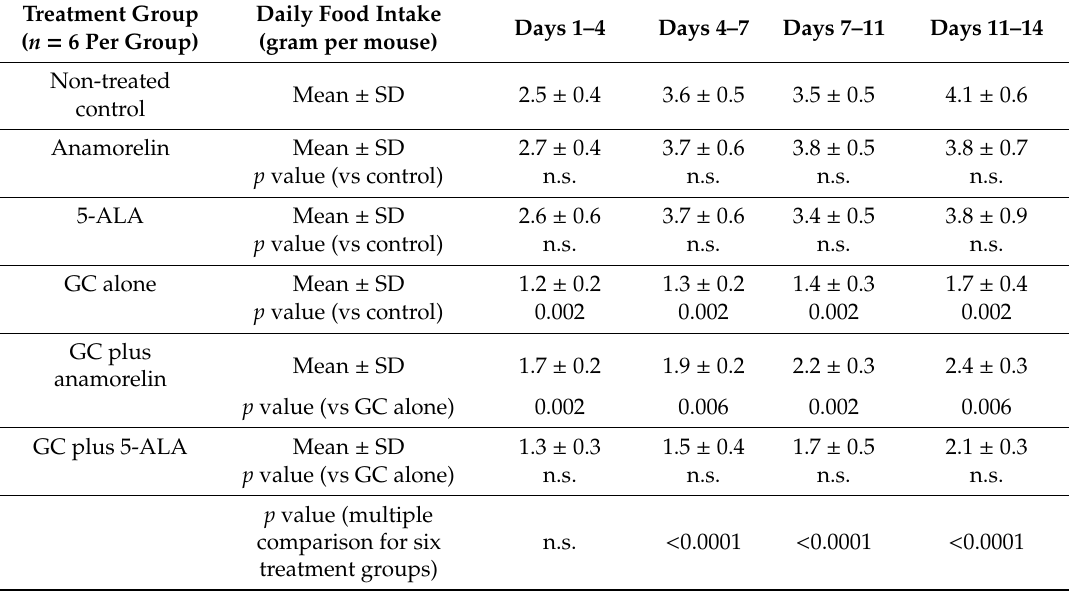
Table 2. Daily food intake during the